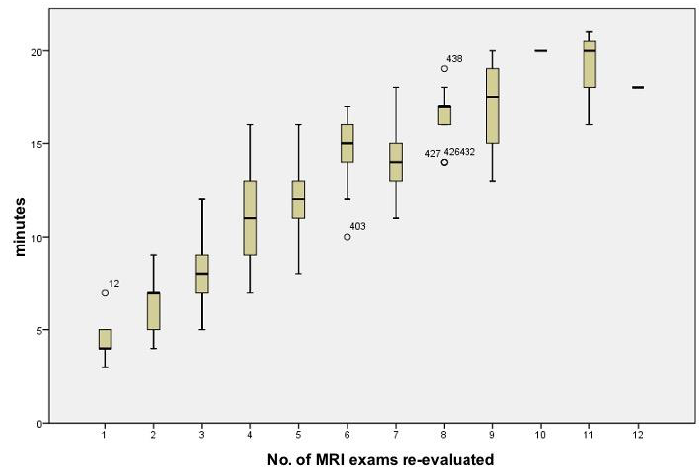
Figure 3. Box plot diagram of the time (minutes) vs. the number of MRI exams evaluated/case.